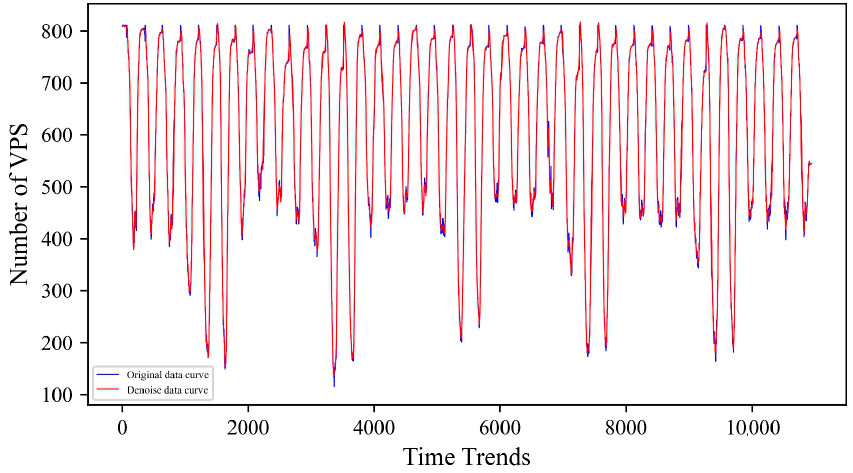
Figure 7. Original and denoised time series.